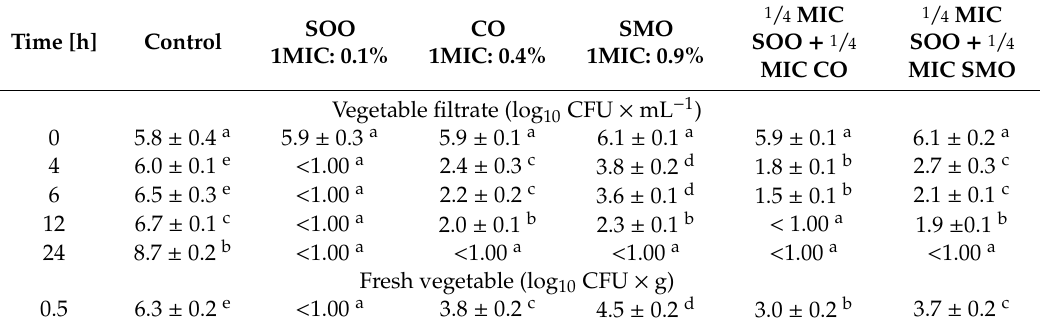
Table 4. Changes in the number of L. monocytogenes in vegetable filtrate and in mixture of fresh cut